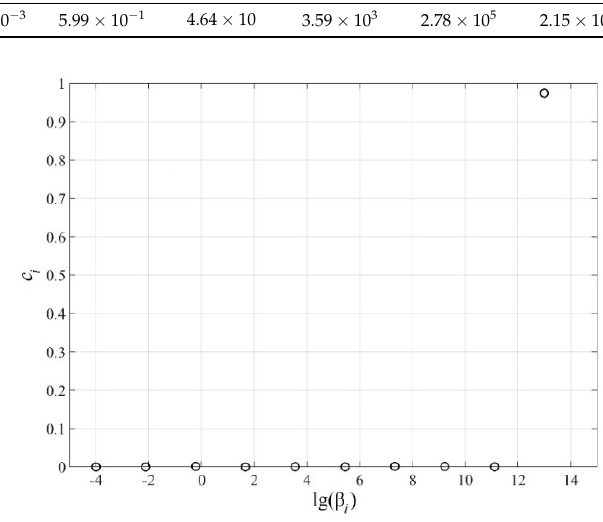
Figure 6. Dependence of 𝑐 (cid:3036) on β